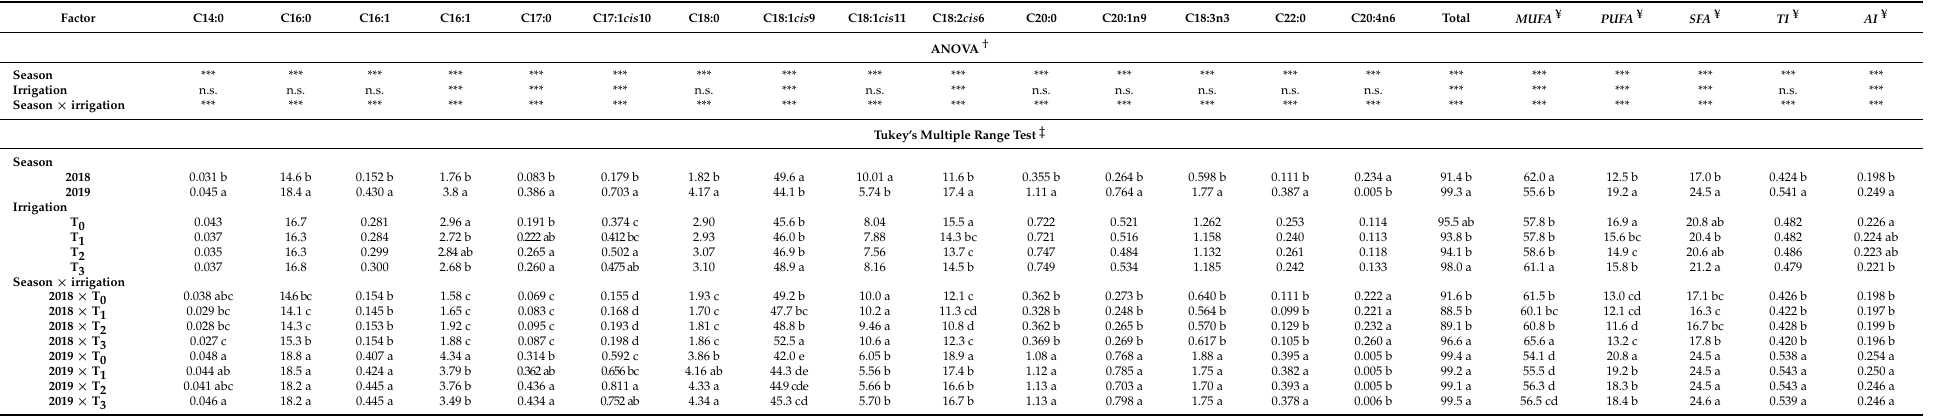
Table 4. Fatty acid composition (% of total fatty acids) in ‘Arbequina’ olive oil samples obtained from a super-high-density olive tree